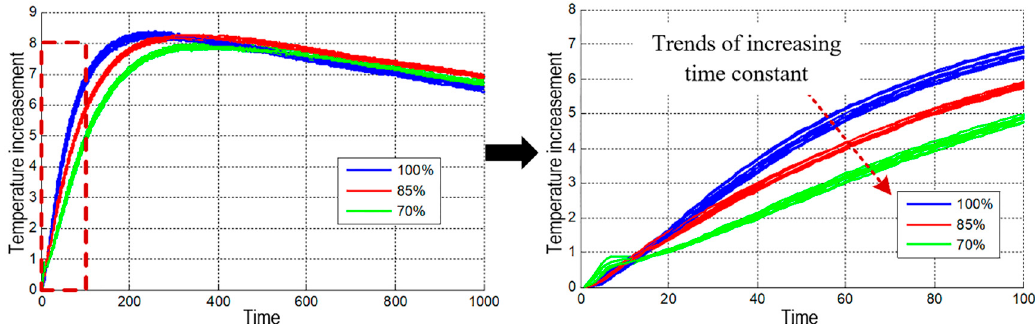
Figure 14. Comparison of thermal transient response curves with varying thermal grease area in the same test area.